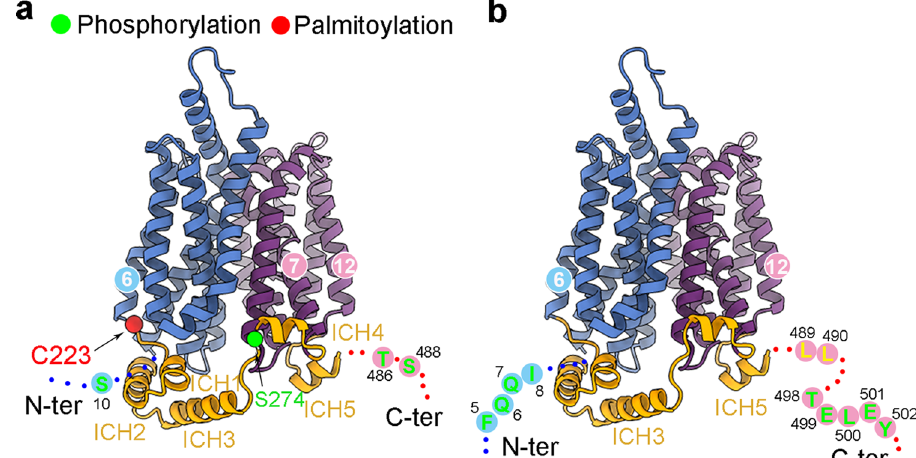
Fig. 5 The intracellular functional motifs on GLUT4. a Posttranslational modi fi cation site on the intracellular segments of GLUT4. Residues that may be subject to phosphorylation and palmitoylation are shown as green and red spheres. Three potential phosphorylation sites, Ser10, Thr486, and Ser488, are invisible. b The intracellular motifs that are involved in the cellular traf fi cking of GLUT4 are localized on the fl exible terminal loops that are not resolved in the cryo-EM structure. This arrangement may ensure cargo recognition independent of the functional states of